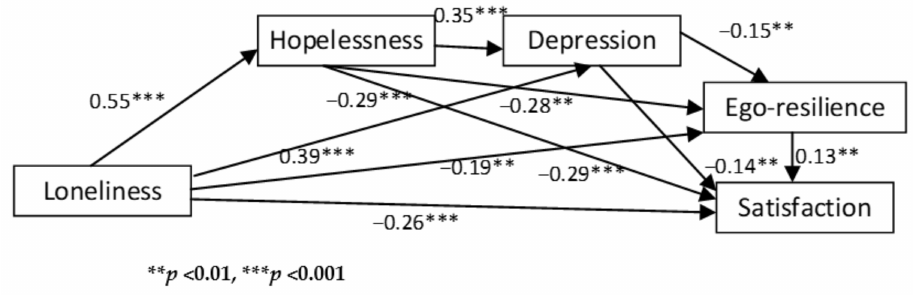
Figure 1. Path analytical model of the inter-relationship between the study variables.